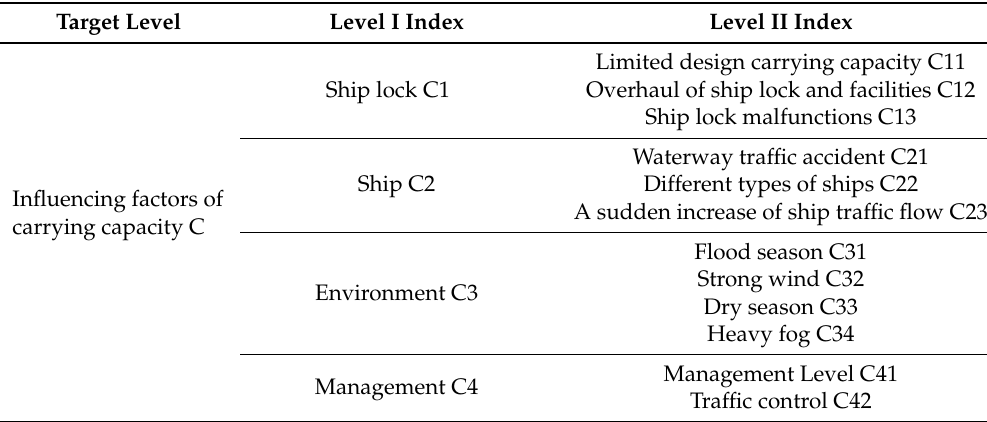
Table 4. Index system of influencing factors.